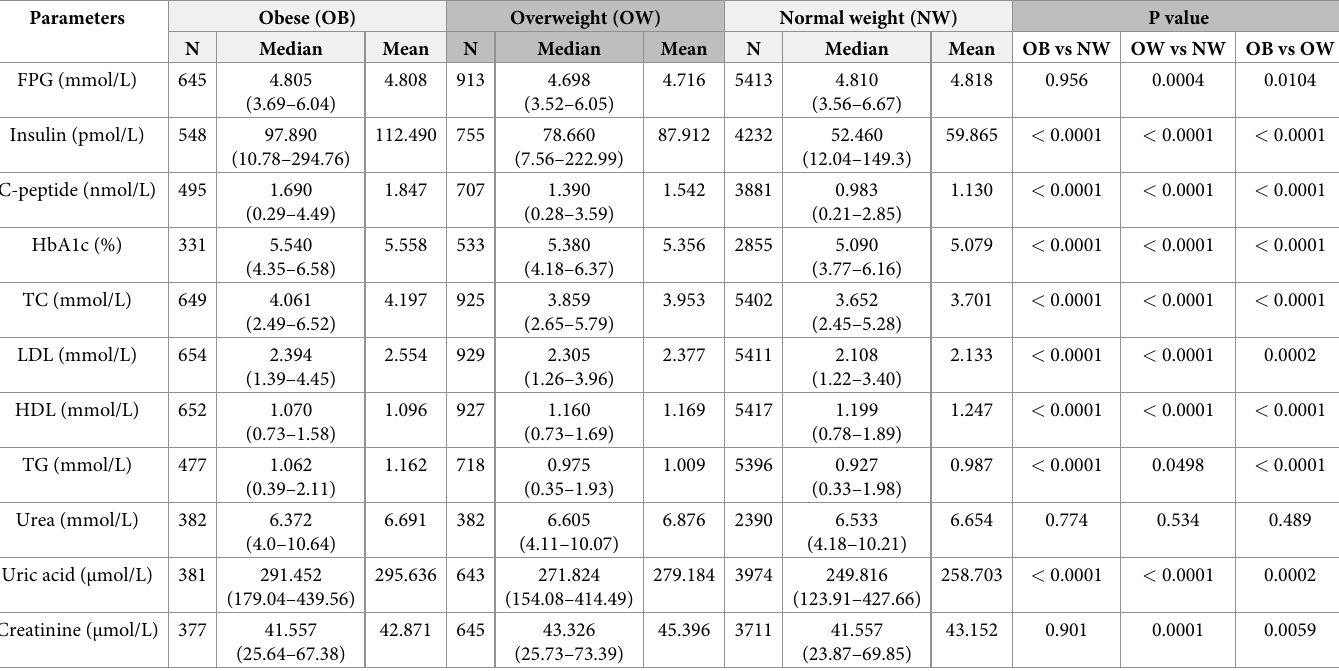
Table 5. Variation of biochemical parameters with BMI during adolescence. Parameters Obese